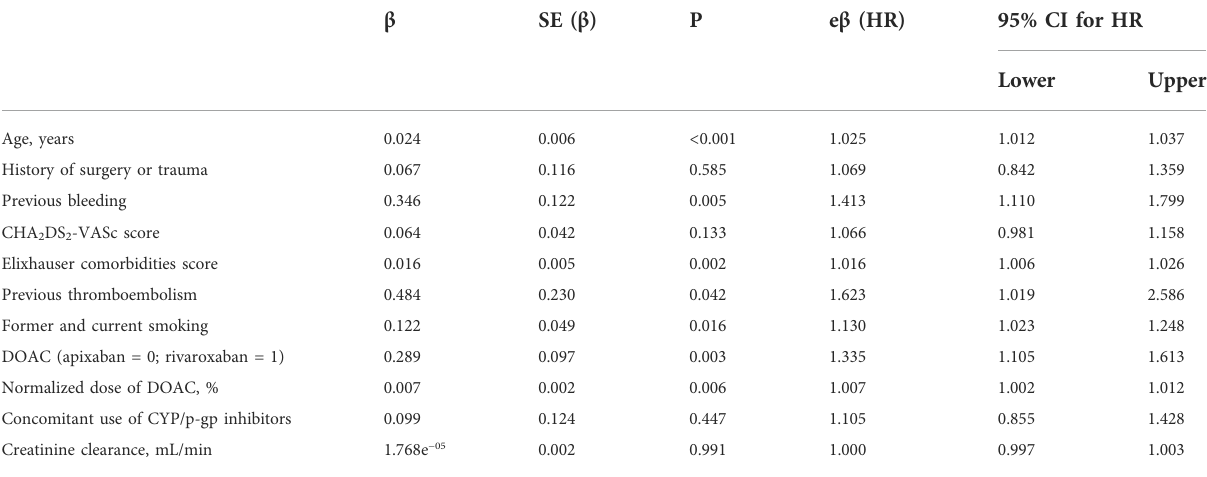
TABLE2Multivariable Coxproportionalhazardsregressionwithtime-varying analysisassessingclinicalcharacteristicsasclinicalpredictorsofmajor + CRNM bleeding from